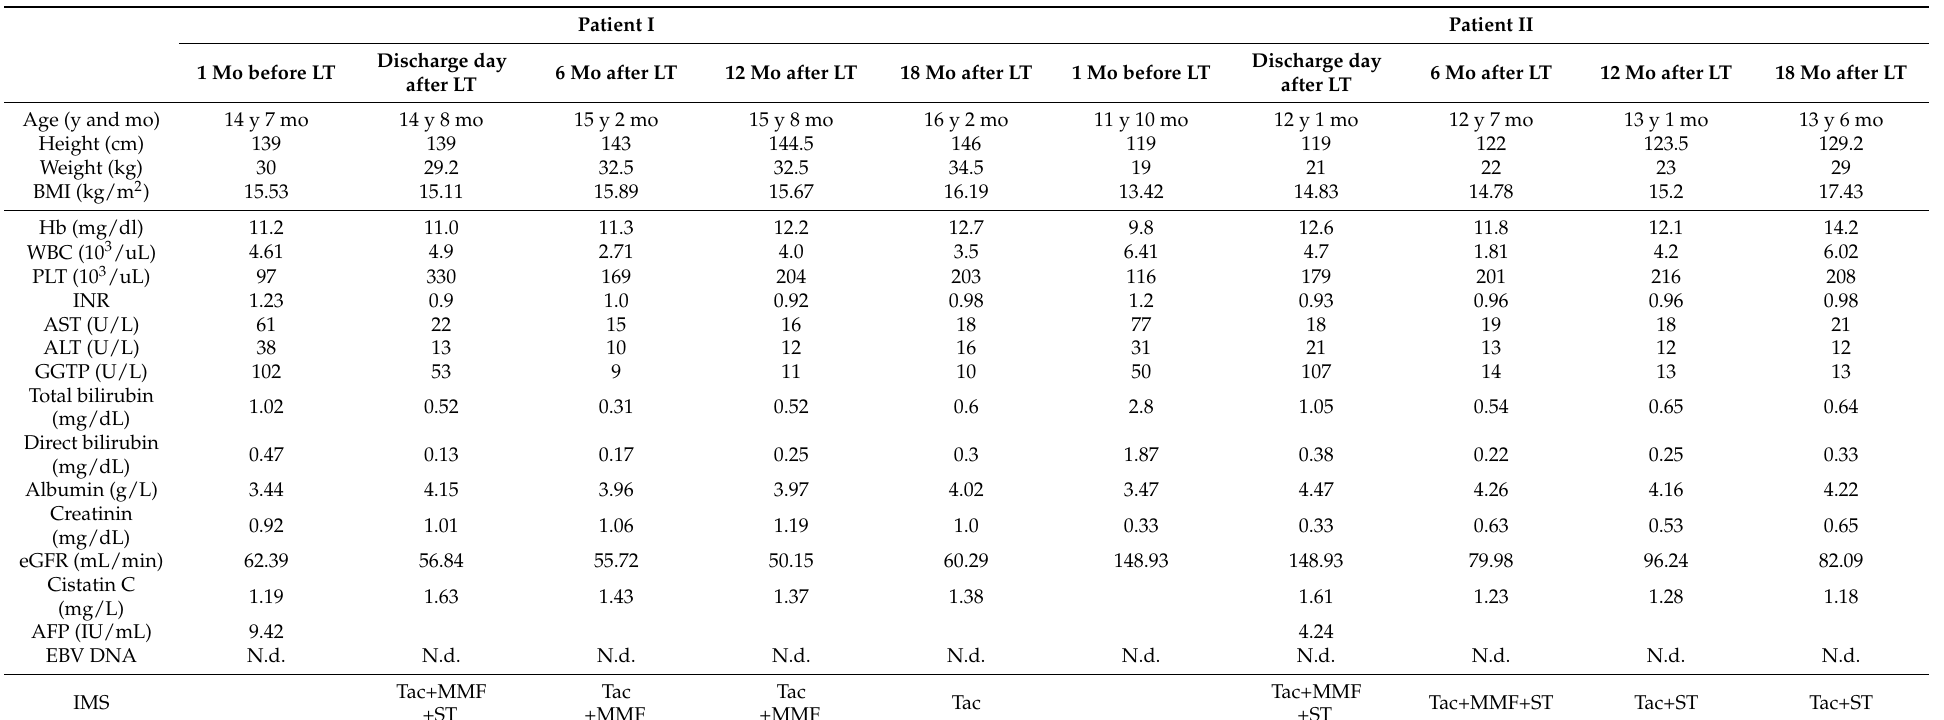
Table 3. Clinical and biochemical data before and in post LT